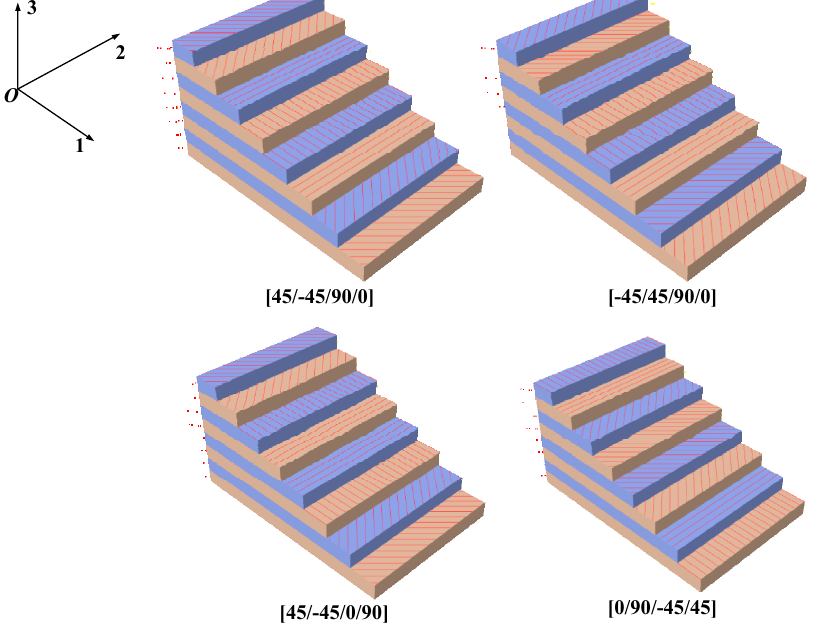
Figure 6. Typical layer orders for CFRP.